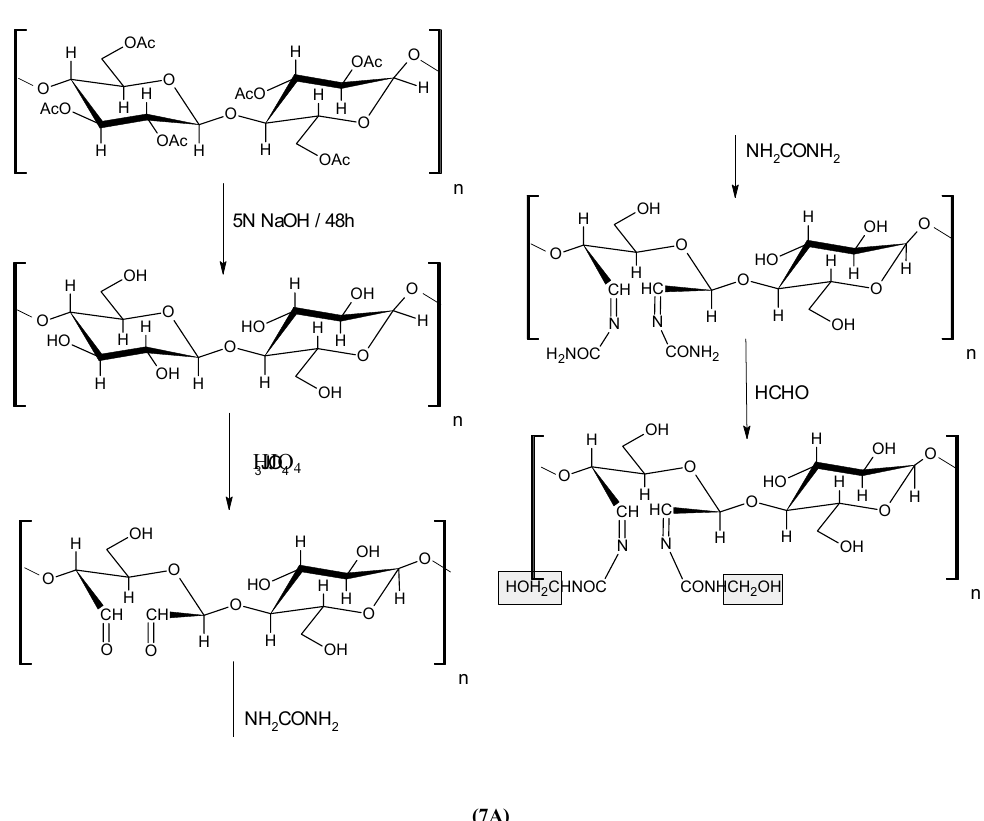
FIGURE 7 . Possible scheme of covalent binding of neutral red and urease to activated triacetylcellulose membrane; A – activation step; B – conjugation